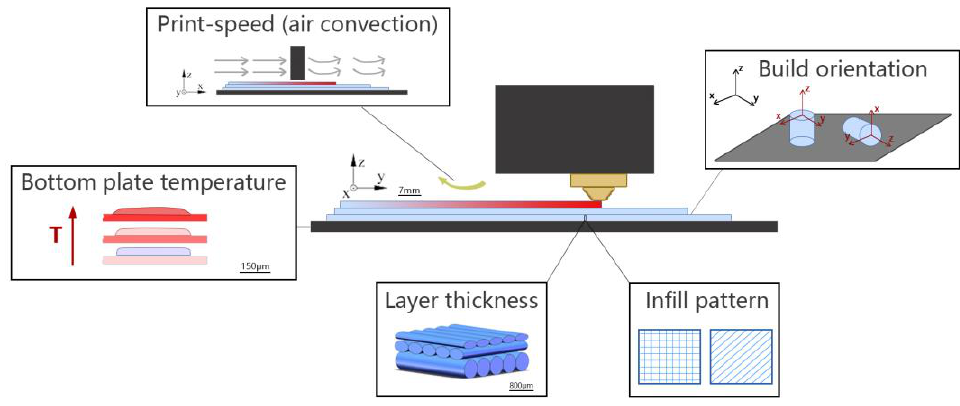
Figure 2. MEAM printing parameters that lead to weak meso-structure.